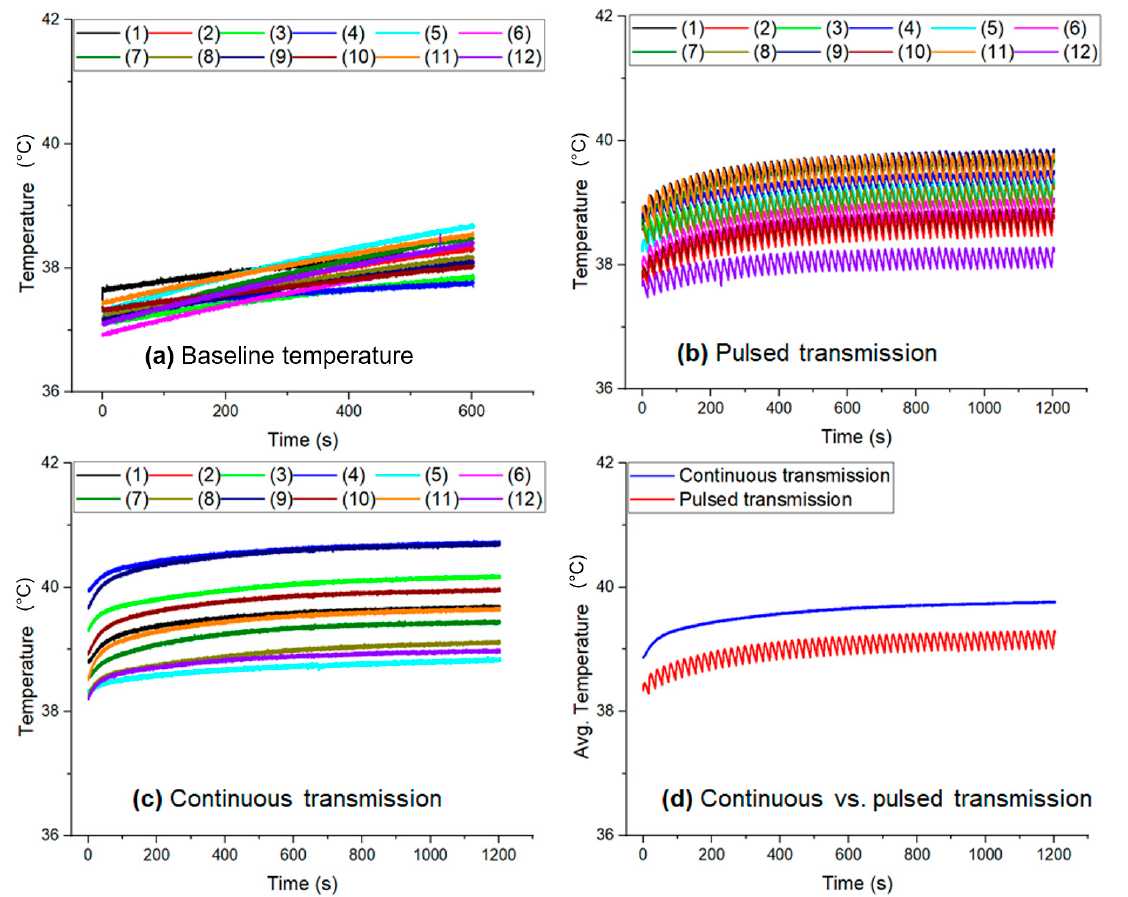
Figure 7. An in vivo temperature measurement from the implanted coil: ( a ) baseline temperature (power is OFF), ( b ) pulsed transmission (5 W LVAD), ( c ) continuous transmission (5 W LVAD), and ( d ) average temperature calculated from ( b , c ) in pulsed and continuous transmissions (for 5 W rated LVAD).